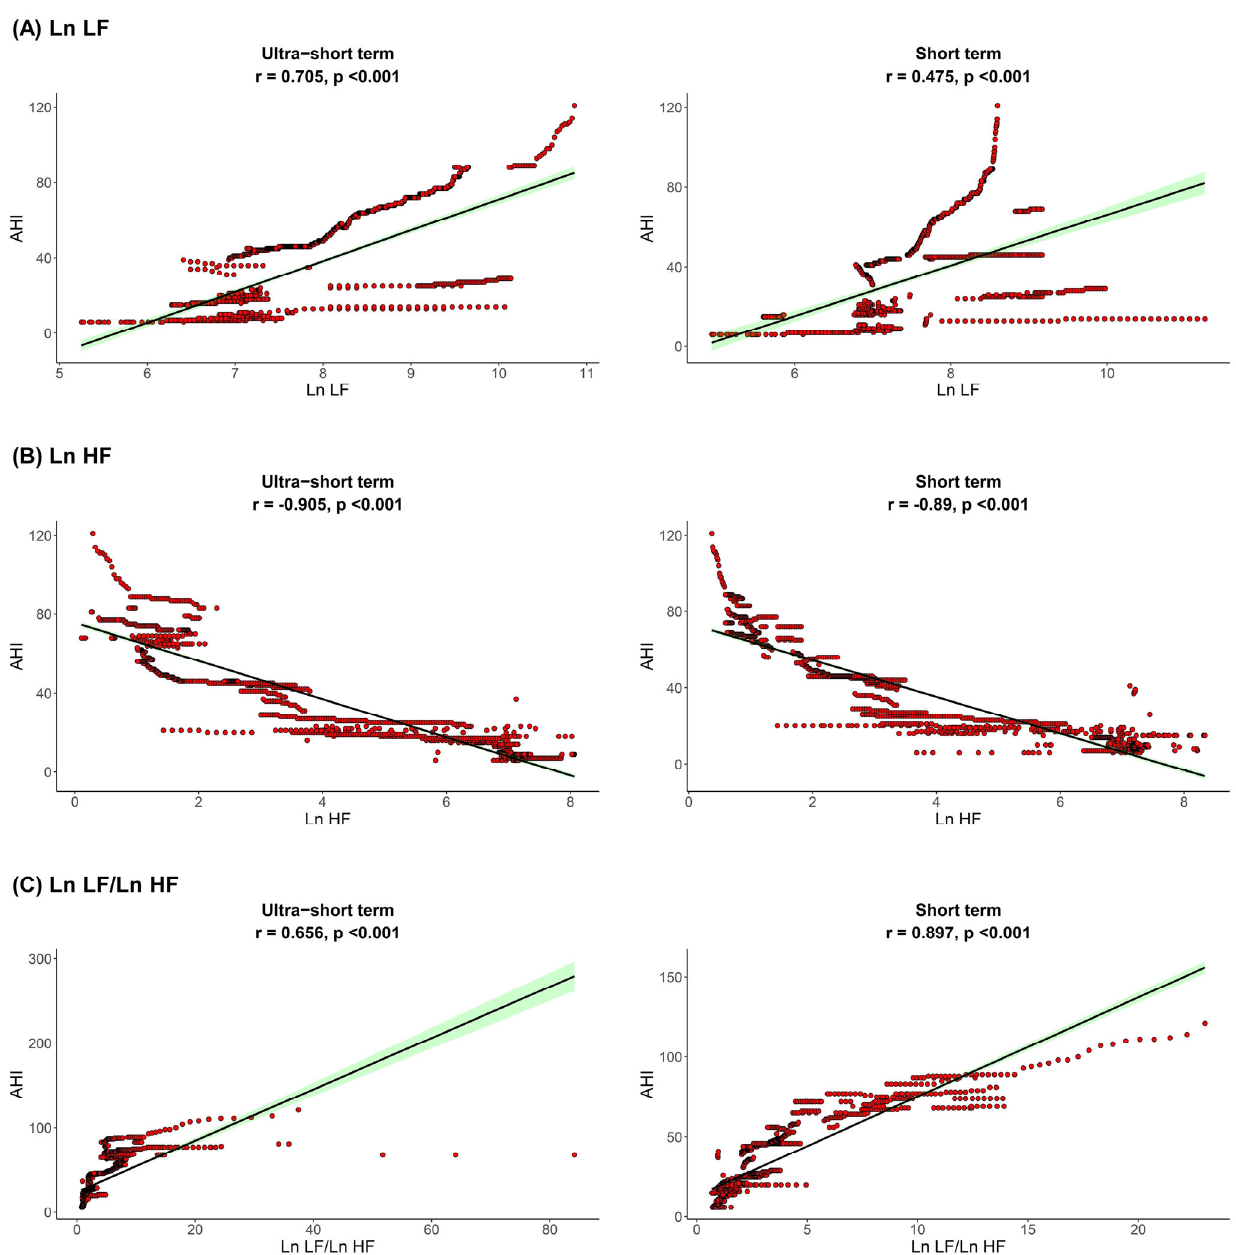
Figure 1. Correlation between AHI ( A ) Ln LF, ( B ) Ln HF, ( C ) Ln LF/Ln HF. Apnea ‐ hypopnea index, AHI; total power, Ln TP; very low frequency, Ln VLF; low frequency, Ln LF; high frequency, Ln HF.